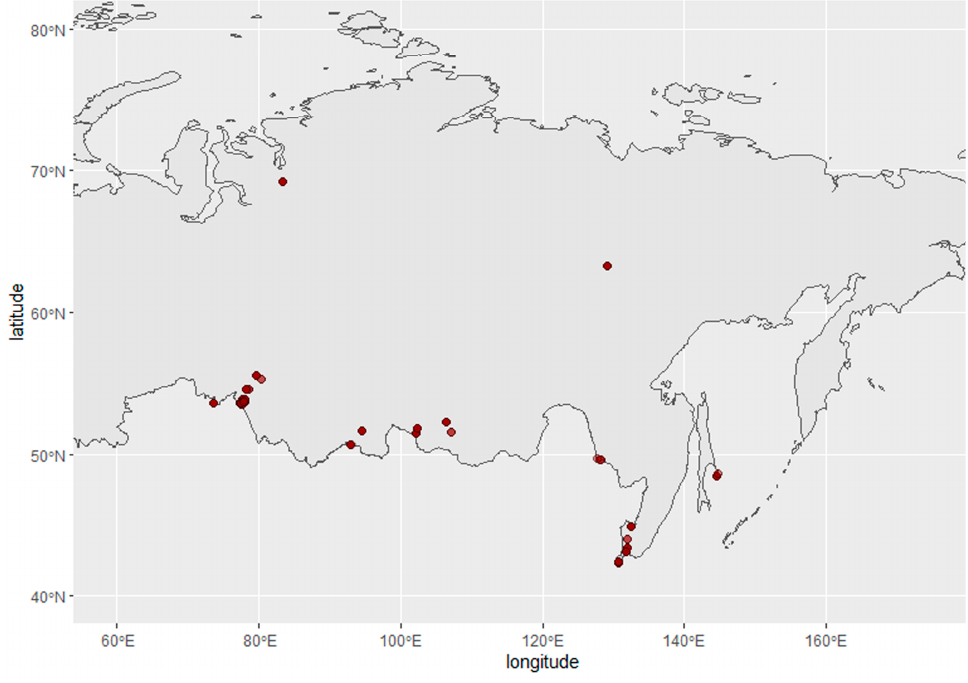
Figure 1. Avian influenza virus surveillance sampling sites in Russia, 2014–2019. Red circles represent sampling sites.